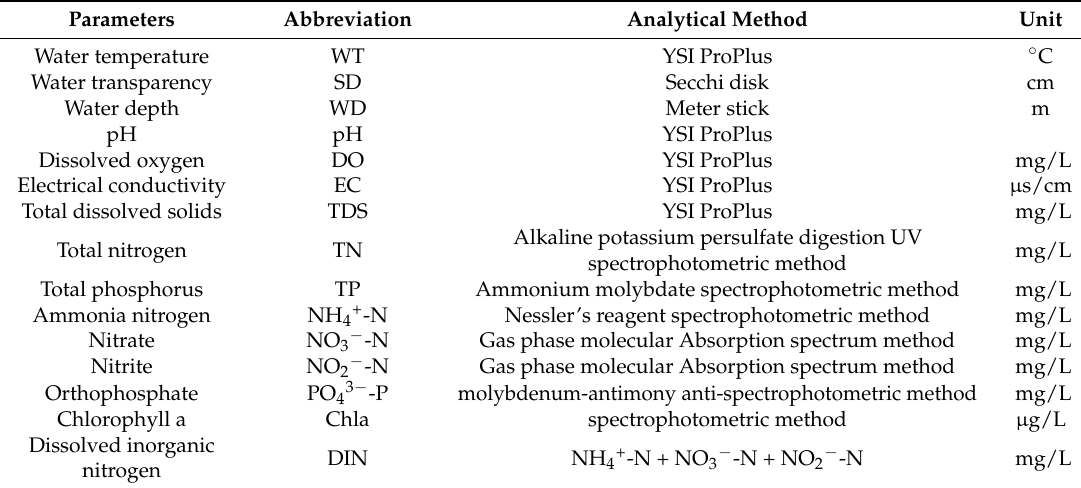
Table 1. The water quality parameters and their abbreviation, analytical method and units.